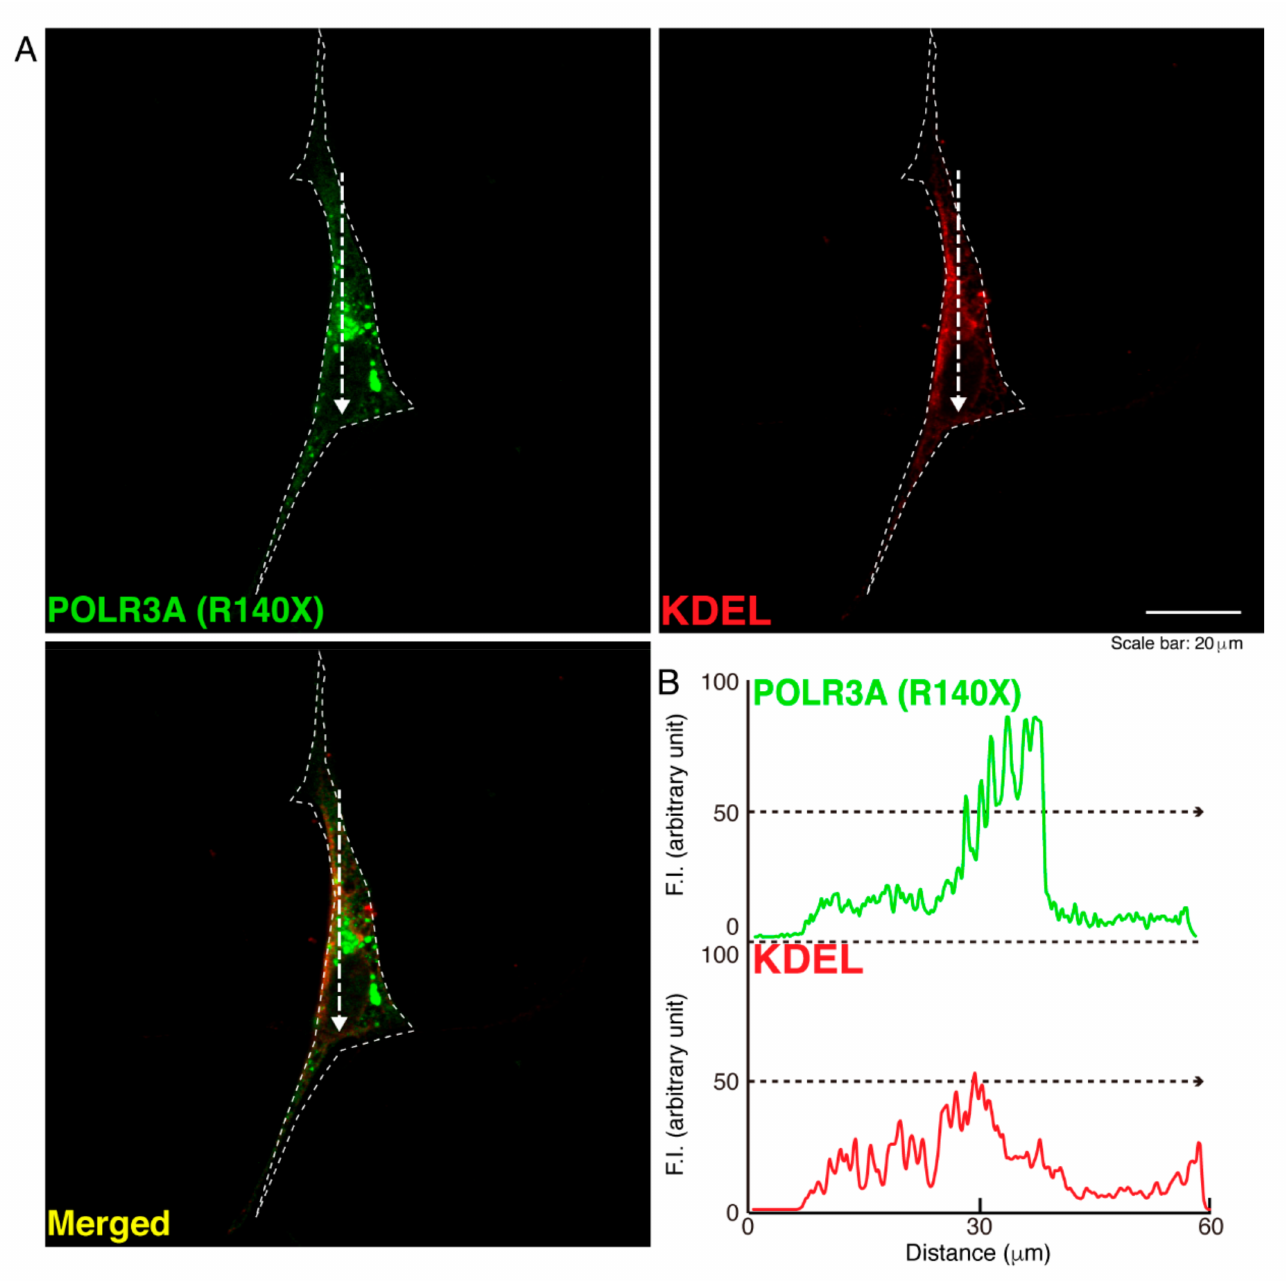
Figure 3. The POLR3A mutant proteins are not co-localized with the ER in cells. ( A , B ) FBD − 102b cells were transfected with the plasmid encoding the POLR3A R140X construct (green) and stained using an antibody against the KDEL antigen (red). Scan plots were performed along the white dotted lines in the direction of the arrows in the color images (green and red as well as merged images). Graphs showing the fluorescence intensities (arbitrary units) along the white dotted lines in the direction of the arrows can be seen in the right bottom panels (black dotted